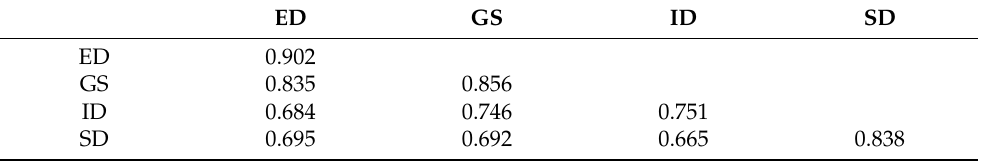
Table 5. Discriminant validity assessment by Fornell and Larcker’s criterion. ED GS ID